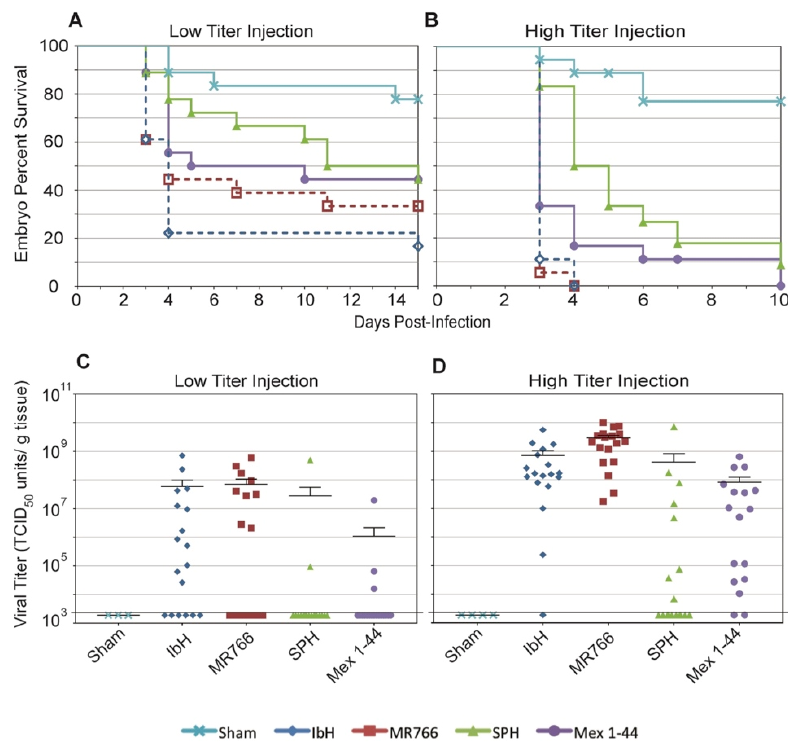
Figure 6. Chicken embryo response to ZIKV infection. Chicken embryo percent survival after: ( A ) low titer ZIKV infection; and ( B ) high titer ZIKV infection. n = 18 for each condition at day zero. Any eggs contaminated with bacteria or fungus were censored from the study. Statistics for these data are listed in Table 6. ZIKV titers of dissected embryonic tissues infected with: ( C ) low titer ZIKV; and ( D ) high titer ZIKV. Each symbol represents one embryo. Mean and SEM are shown for each condition. Percent survival and titers for sham ‐ injected eggs are also shown. The value 1.89 × 10 3 TCID 50 units/gram of tissue (indicated by a bold horizontal line on the graphs) represents the lowest limit of detection of the TCID 50 assay; therefore, data points at this level are considered negative for ZIKV.